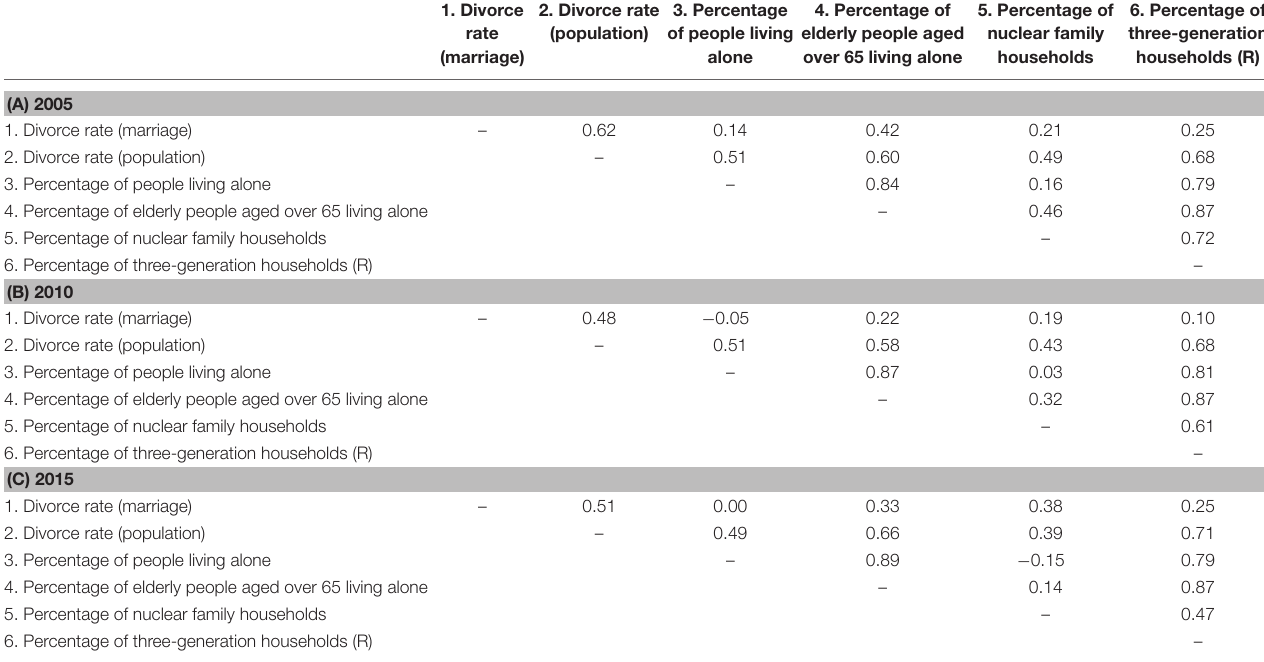
TABLE 1 | Correlation coefficients among